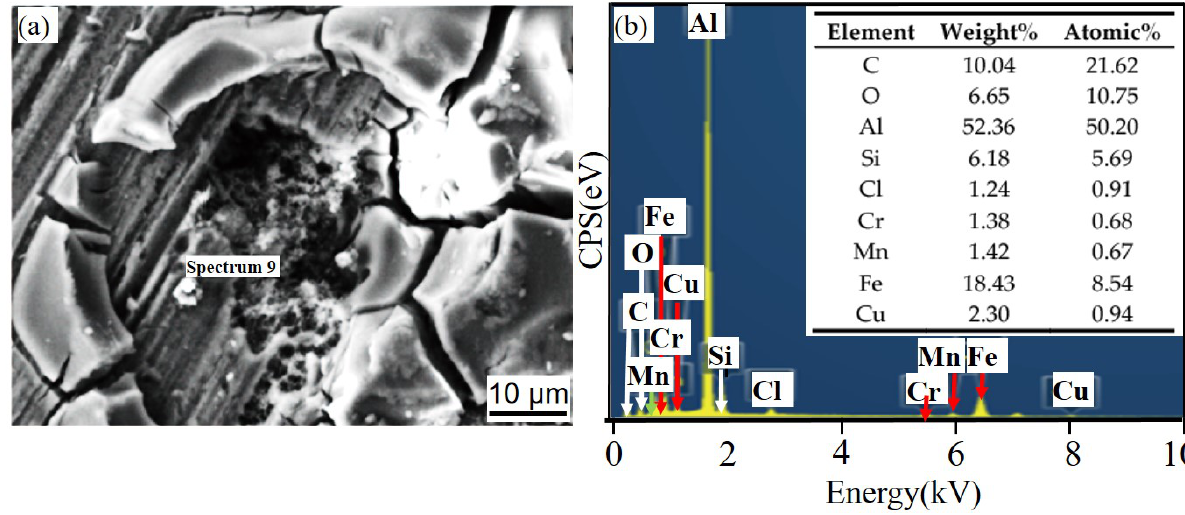
Figure 22. EDS of matrix cracks in 6061Al alloy after SL for 61 days. ( a ) SEM image of matrix cracks; ( b ) EDS of matrix cracks.